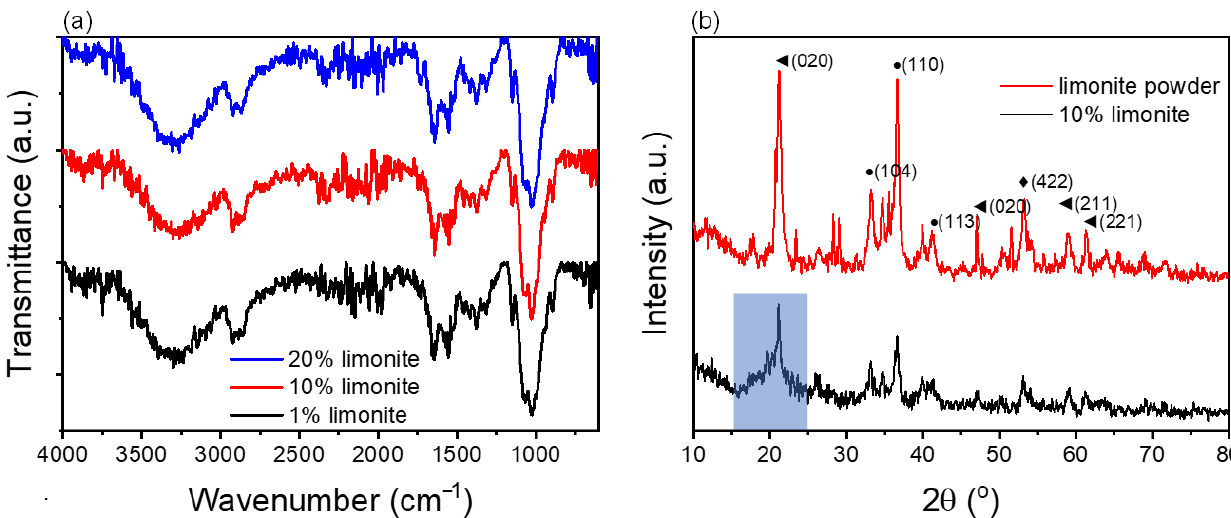
Figure 2. ( a ) FTIR spectra for chitosan fibers containing various amounts of limonite powder. ( b ) XRD diffractogram for the limonite powder and 10% limonite – chitosan fiber with label crystal phase